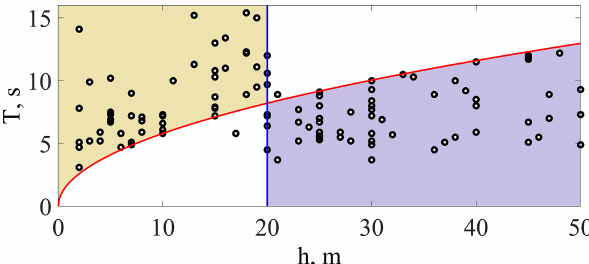
Figure 9. Period of freak waves plotted against the water depth of their occurrence; the solid red line corresponds to Eq.